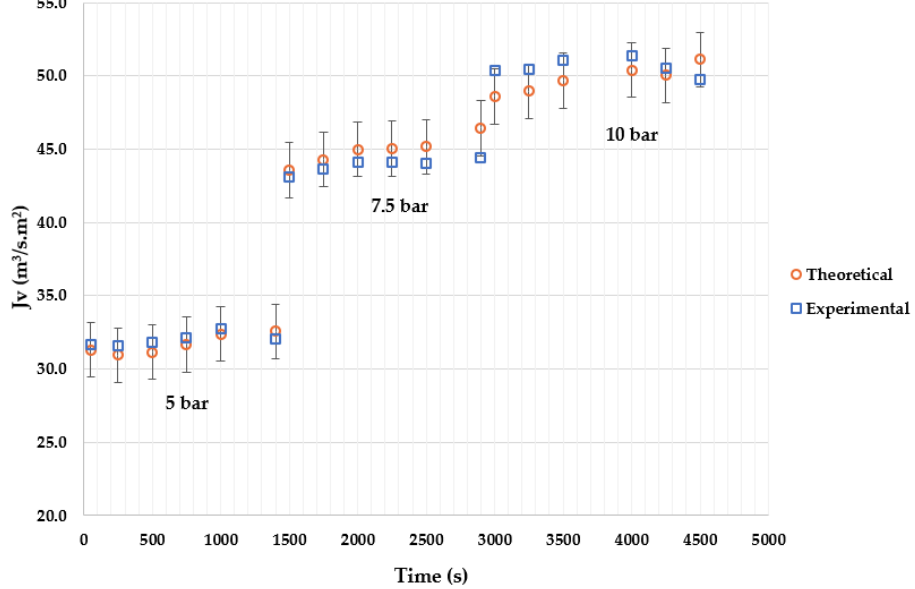
Figure 18. Theoretical vs. experimental As comparison: maximum error at high concen- tration.